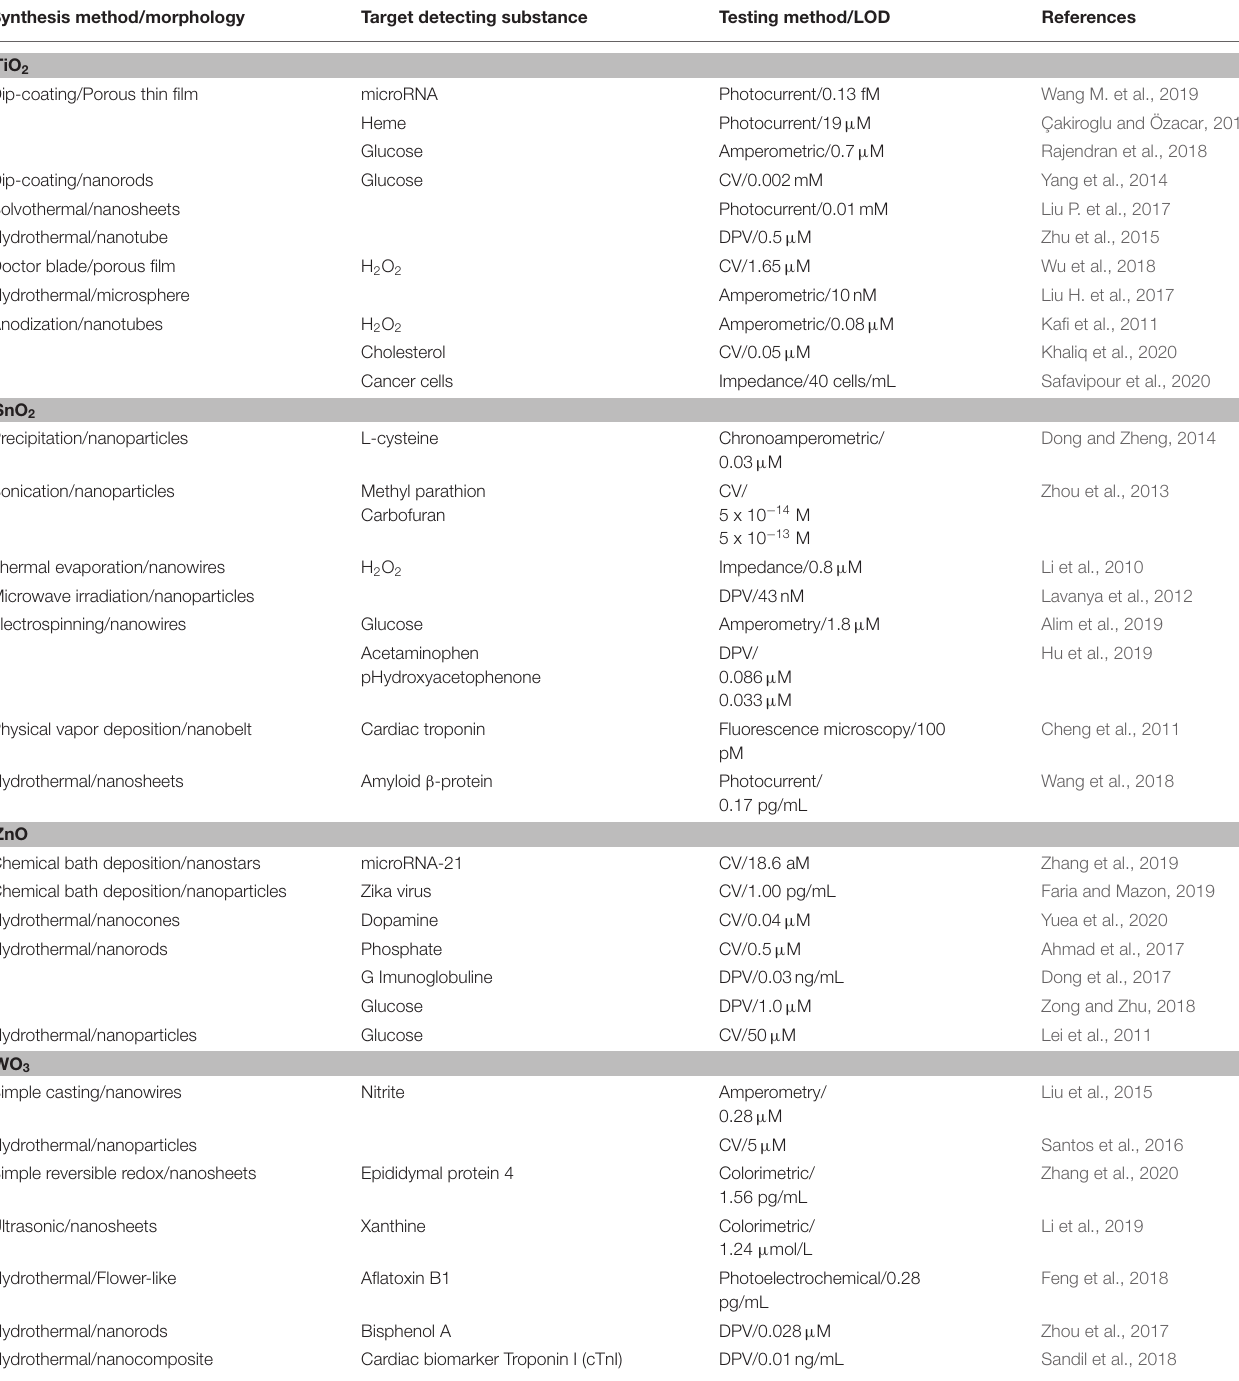
TABLE 1 | Representative studies on metal oxide semiconductors used in